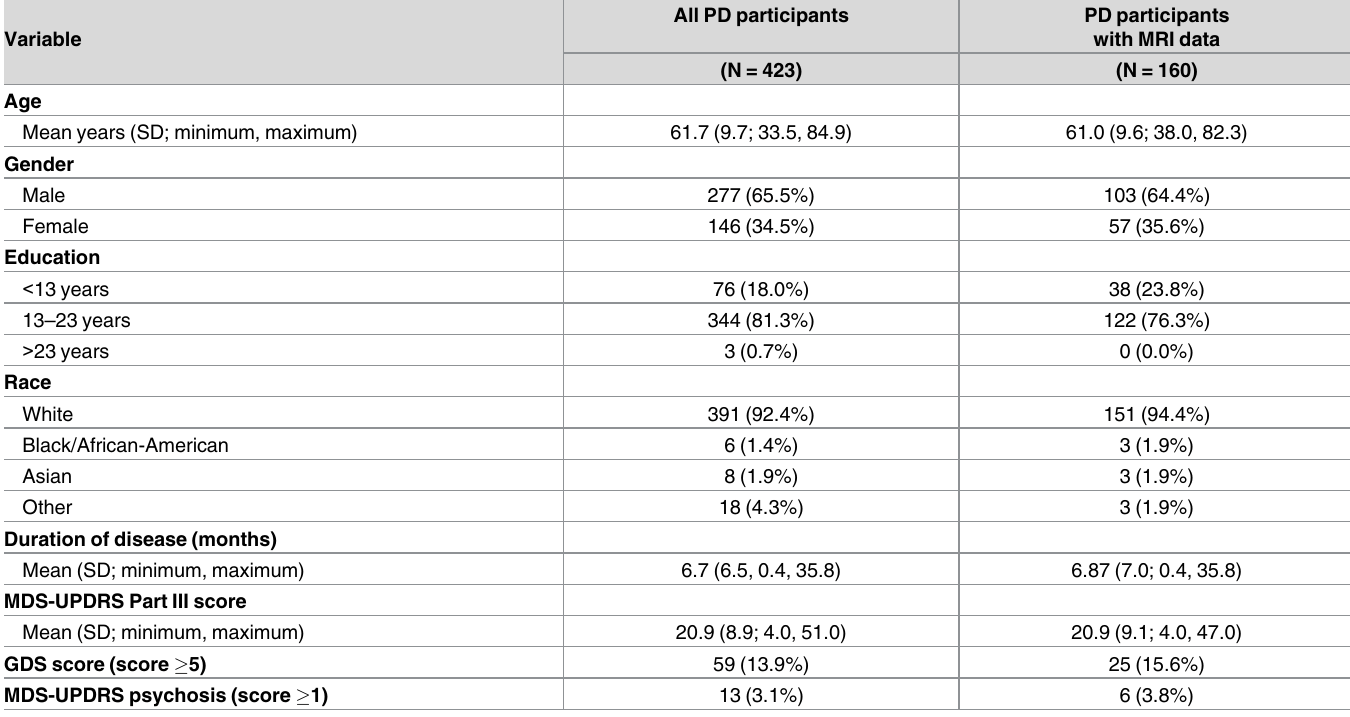
Table 1. Baseline demographic and clinical characteristics.